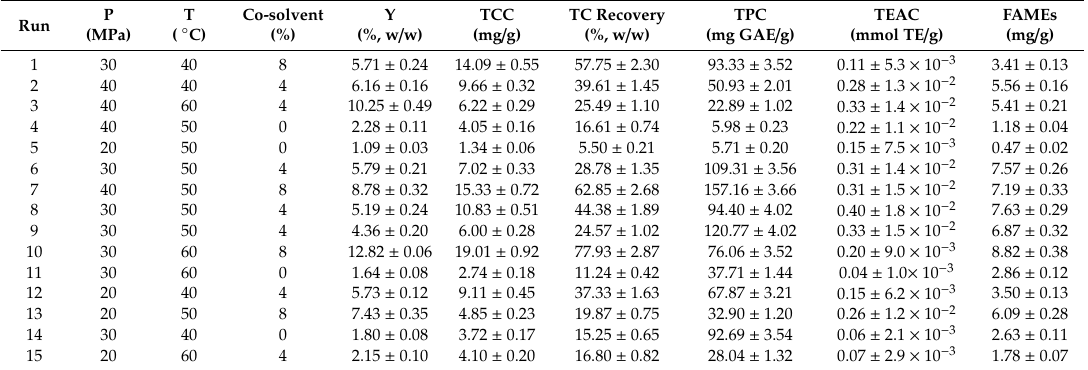
Table 2. Extraction yields (Y), total carotenoids content (TCC), total carotenoids recovery (TC recovery), total phenol content (TPC), TEAC antioxidant method, and fatty acid methyl ester (FAMEs) by SFE from freeze-dried Isochrysis galbana using Box-Behnken experimental design. The general parameters were biomass loading = 2.0 g, CO 2 flow rate = 7.4 g / min, extraction time = 120